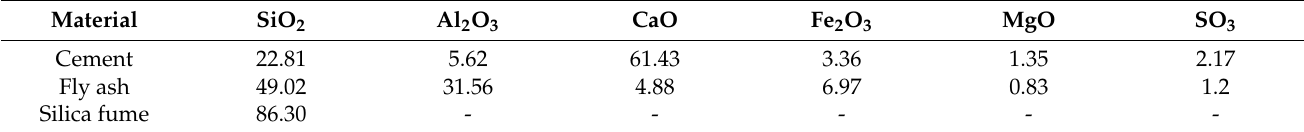
Table 3. Main chemical components of cement, fly ash and silica fume (%).